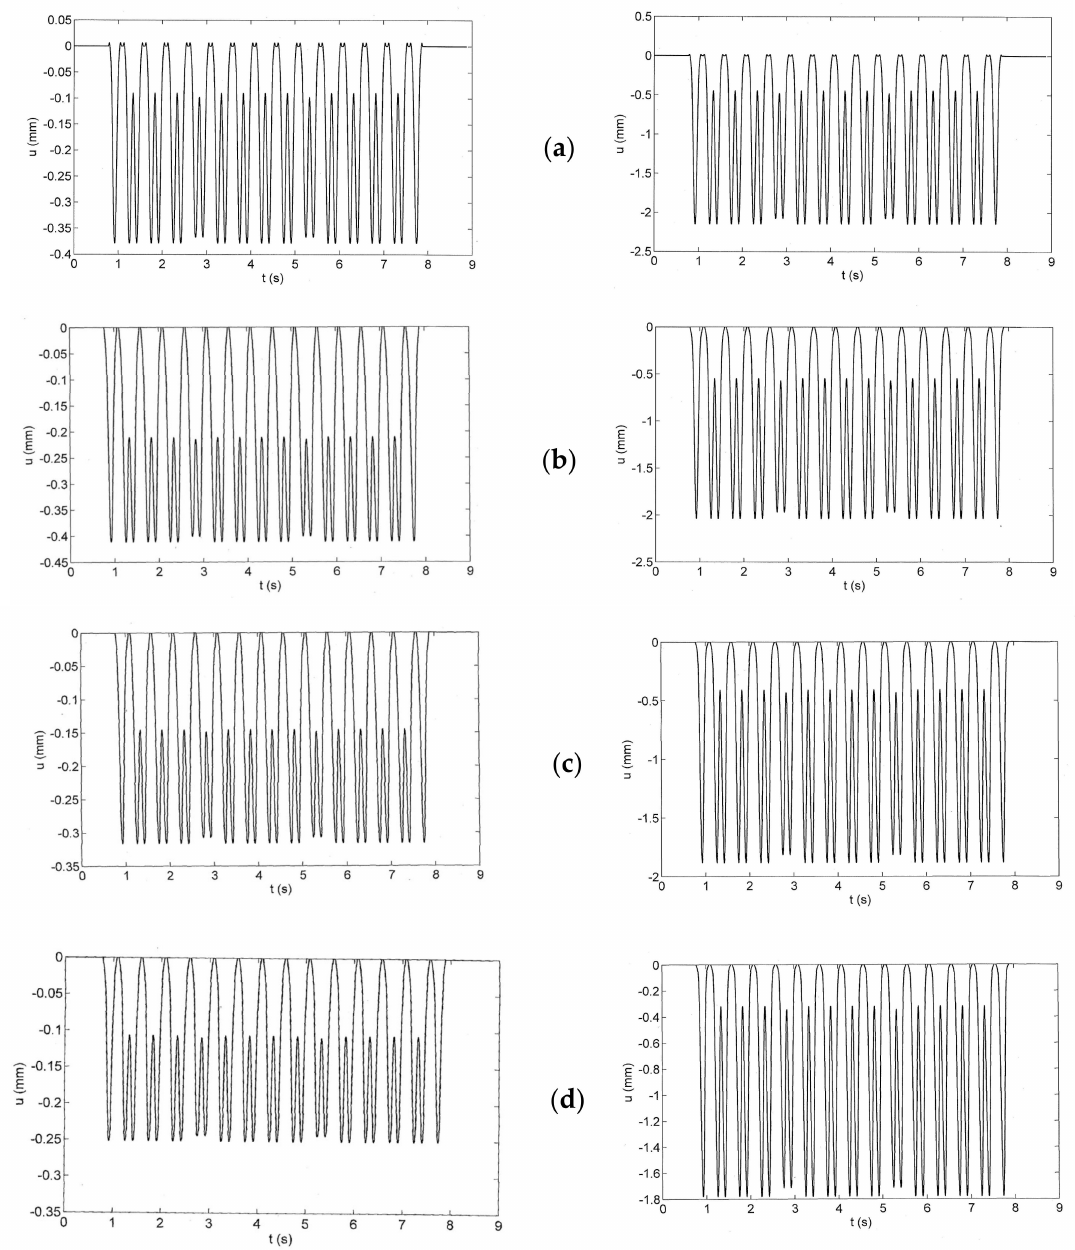
Figure 12. Calculated track plate displacements under train passages: ( a ) FEM model; FEBEM models with v S = ( b ) 150, ( c ) 175, and ( d ) 200 m/s, intact slab track (left) and damaged slab track (gap of L D = 5.85